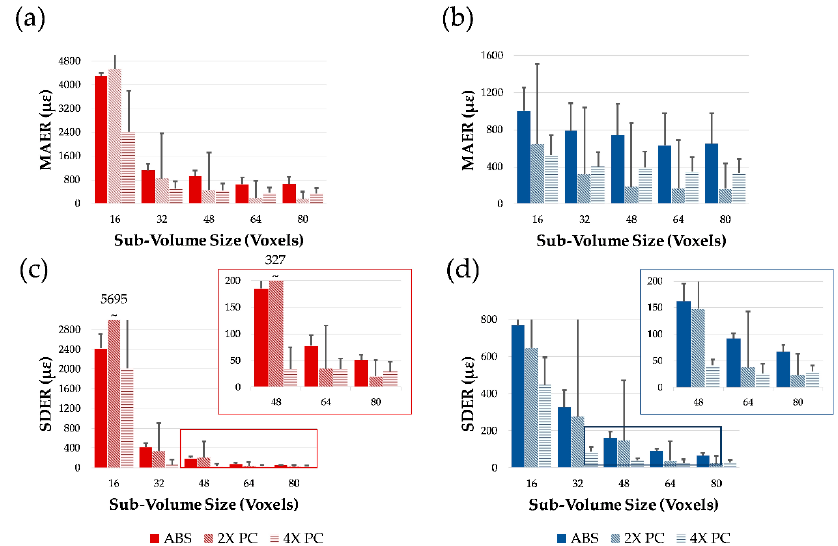
Figure 3. Strain errors of specimens kept in PBS during XCT imaging (CB2–4). ( a , b ) Mean absolute error (MAER) and ( c , d ) standard deviation of the error (SDER) are shown for ( a , c ) the articular cartilage region and ( b , d ) the mineralized region of the specimens in absorption (ABS), 2× and 4× propagation ‐ based phase ‐ contrast (PC) at varying sub ‐ volume sizes.